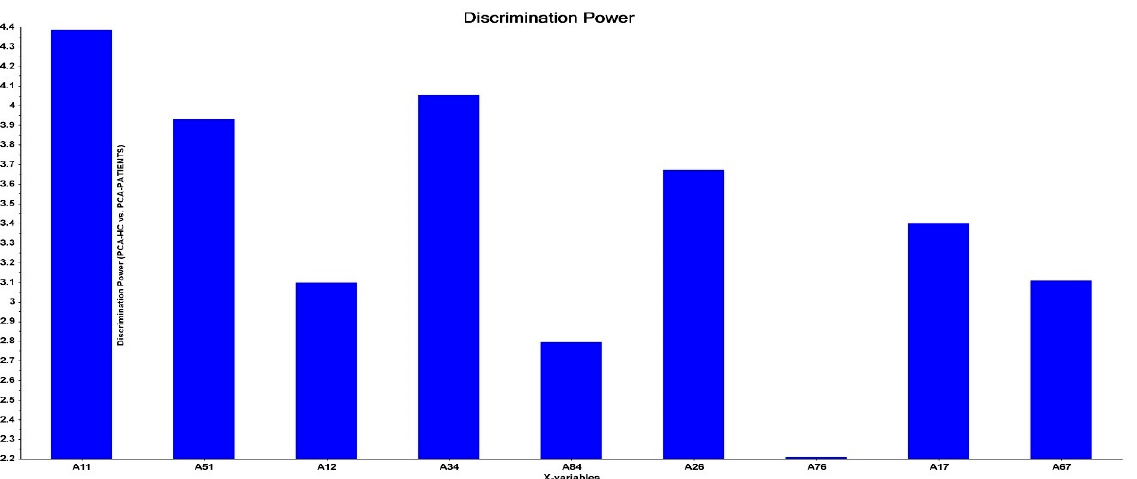
Figure 1. Discrimination power of the nine significant connections. (A11 = self-inhibition of the AI, A51 = ACC → AI, A12 = AI → IFG, A34 = MFG → FEF, A84 = HPC → FEF, A26 = IFG → SPL, A76 = AMY → SPL, A17 = AI → AMY, A67 = SPL → AMY.)